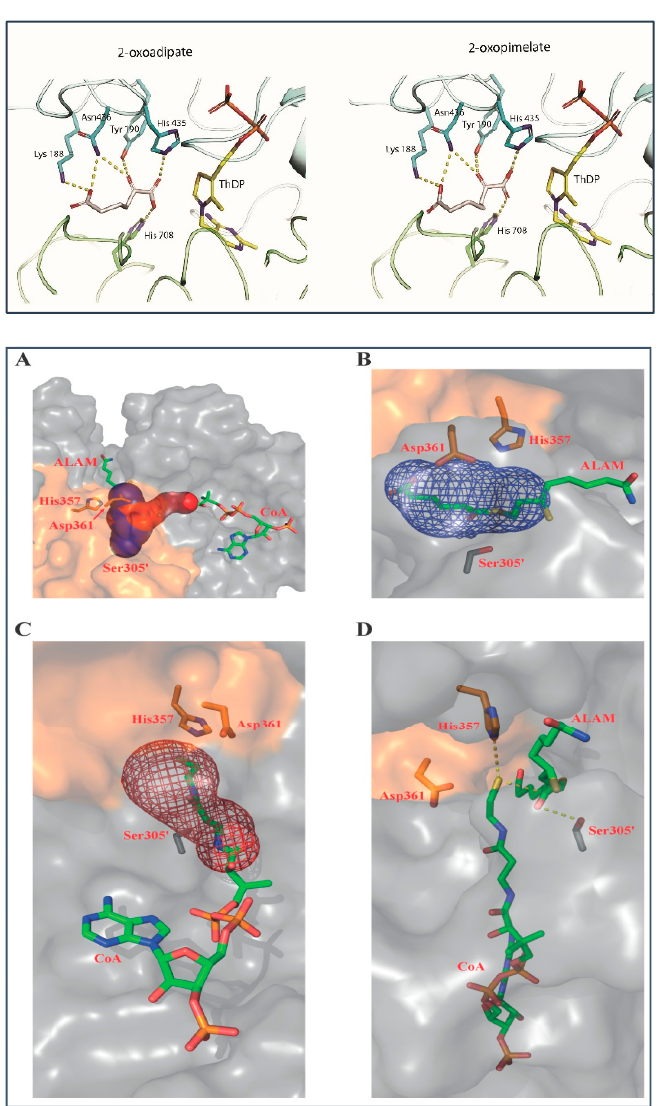
Figure 4. ( Top ) The active site of the E1a showing the binding environment of the modeled OA and of OP. The ThDP cofactor in the V-shaped conformation and Mg 2+ binding sites are shown in yellow and in orange , respectively. The E1a active site is located at the interface between the two subunits of the E1a α 2 -homodimer shown in cyan and green . Figures were generated using PyMOL version 2.3.2. [31]. The substrate docking was performed as reported in [16] using coordinates reported for E1 (6U3J). Figure 4 ( Bottom ) Interactions in the E2o active center on substrate binding. ( A ) The E2o active center showing two channels with the respective substrates modeled via energy minimization: the adipoyl- lipoamide moiety (ALAM) binding channel (in blue ) and the CoA binding channel (in red ). The two adjacent monomers of the E2o core domain are shown in gray and in gold . ( B ) The E2o active center channel with ALAM incorporated ( blue mesh) showing the surrounding catalytically important residues. ( C ) The E2o active center channel with the incorporated CoA ( red mesh) and the surrounding catalytic residues. ( D ) Interaction network among the catalytic residues and ALAM and CoA substrates in the active site of E2o. Selected interactions are designated by yellow dashed lines. Substrate docking was performed as reported in [29] using coordinates reported for dihydrolipoamide and CoA substrates when complexed with the A. vinelandii E2p core (PDB IDs: 1EAE and 1EAD, respectively)